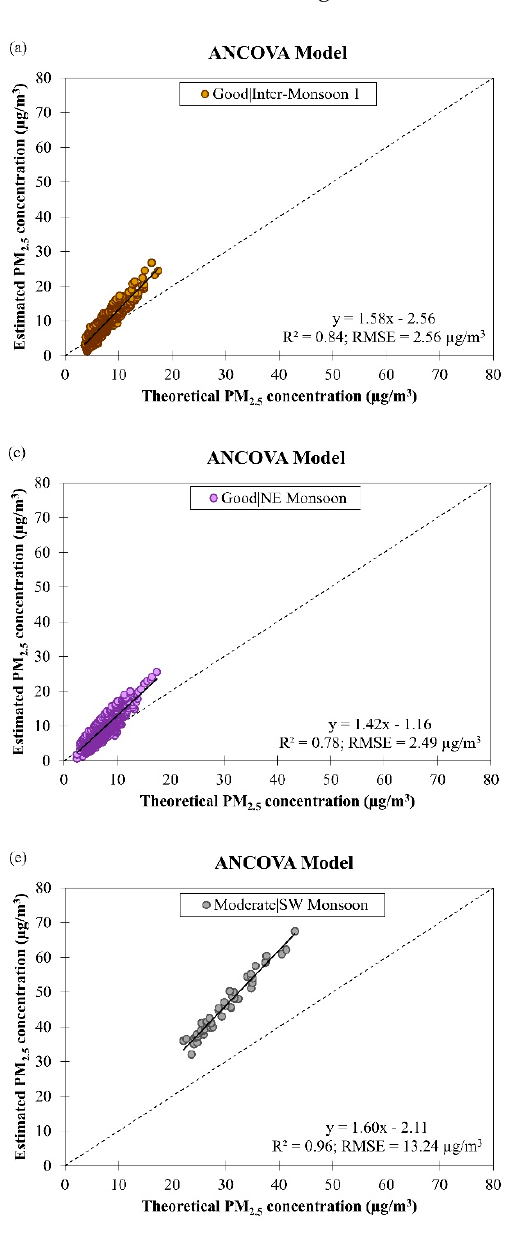
Figure 14. Scatter plots of estimated daily PM 2.5 concentration against theoretical daily PM 2.5 concentration by ANCOVA model for ( a – d ) good air quality condition during different monsoon seasons and ( e ) moderate air quality condition during SW monsoon in Brunei Darussalam from Janu-